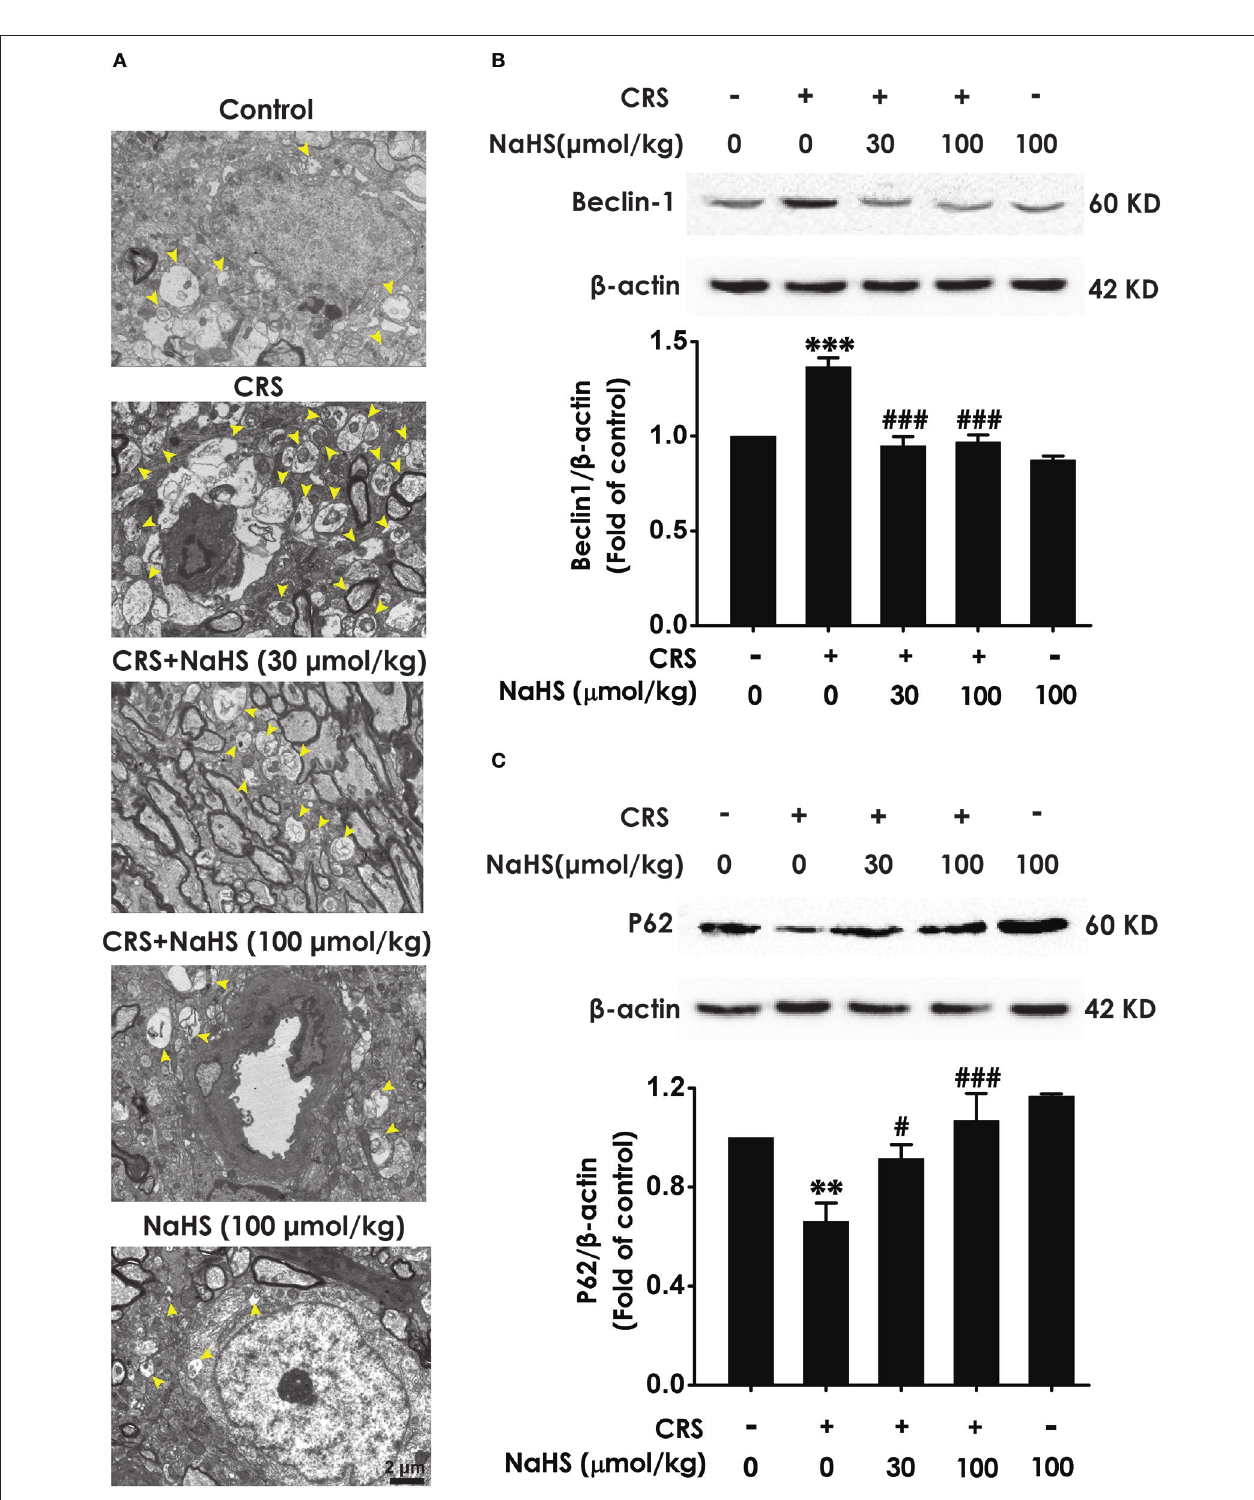
FIGURE 4 | Effect of H 2 S on the excessive autophagy in the hippocampus of CRS-exposed rats . SD rats were cotreated with CRS and NaHS (30, 100 µ mol/kg, i.p.) for 4w. The number of hippocampal autophagosomes (A) was detected by transmission electron microscopy. The arrowhead marked autophagosomes. The expression of beclin1 (B) and P62 (C) were detected by western blot and β -actin was used as an internal control. Values are expressed as means ± SEM ( n = 3). ** P < 0.01, *** P < 0.001, vs. control group; # P < 0.05, ### P < 0.001, vs. CRS-treated alone group.